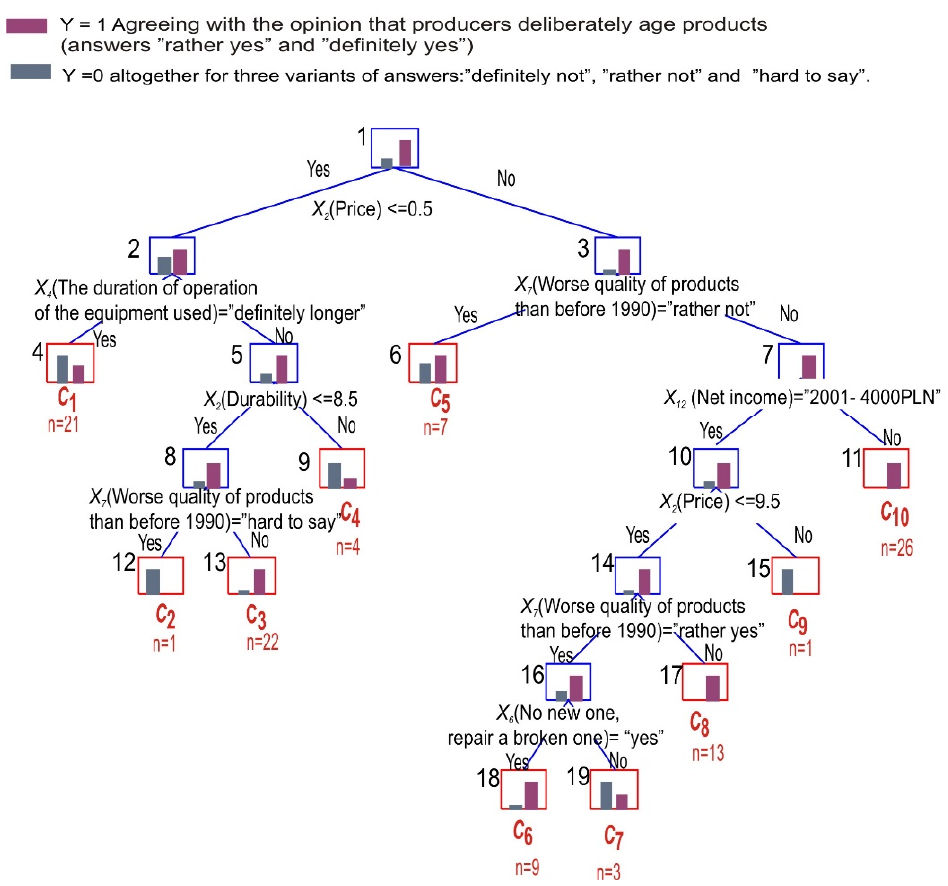
Figure 3. Classification tree for identifying the deliberate aging of products by manufacturers. Source: own study. Table 9. Classes of respondents agreeing with the statement about the deliberate aging of products by producers so that customers buy durable goods more often.